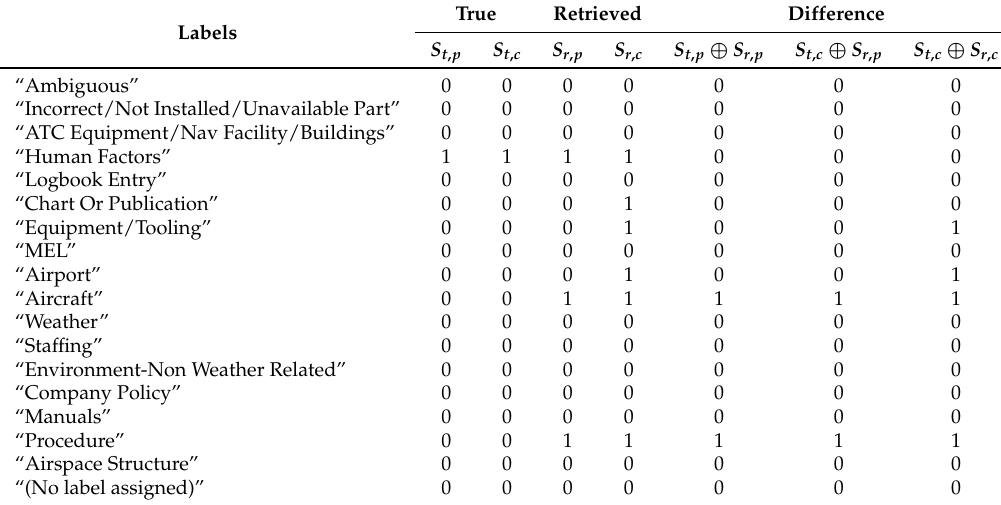
Table A1. Boolean truths for each label, retrieved values, and their differences for the narrative taken from ACN 819,963, coded as “human factors” for primary problem and “human factors” for contributing factors . Here, S represents the string containing the boolean and the subscripts t , r , c , and p , represent the truth, retrieved, primary problem, and contributing factors, respectively.